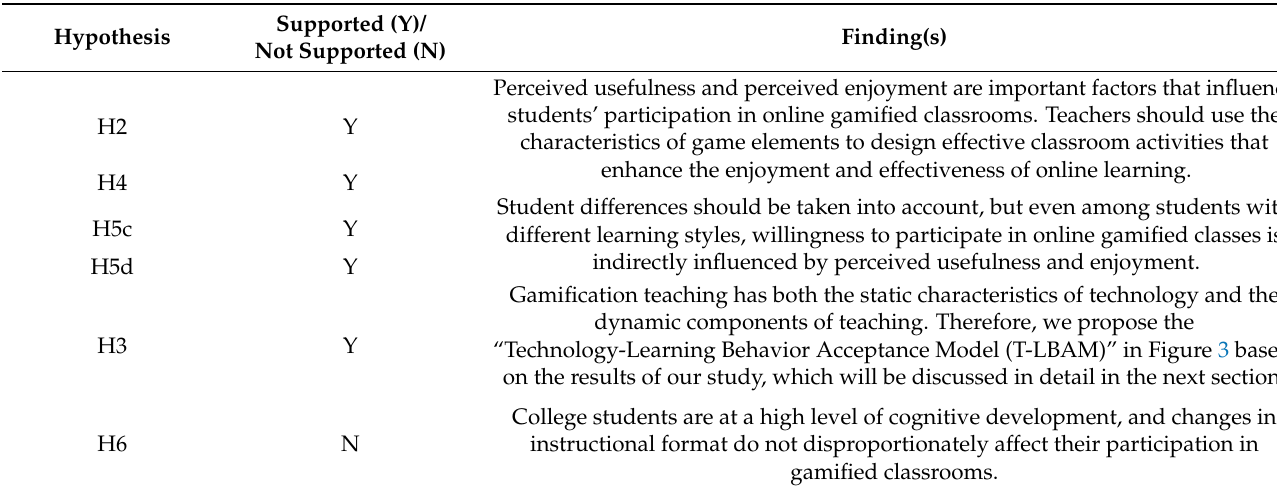
Table 10. Major strategic